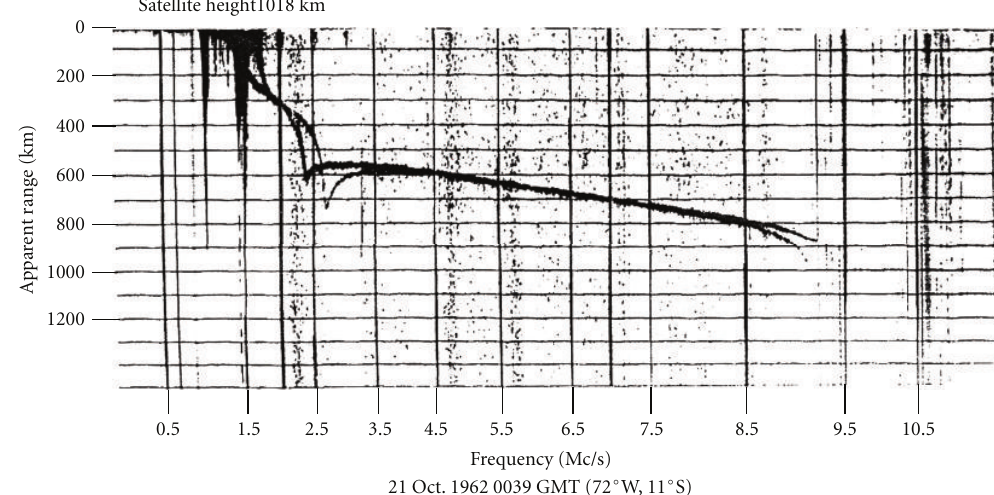
Figure 4: Ionogram recorded by topside sounding onboard Alouette-1 satellite that provides an evident cusp example (from Lockwood and Nelms [18]).